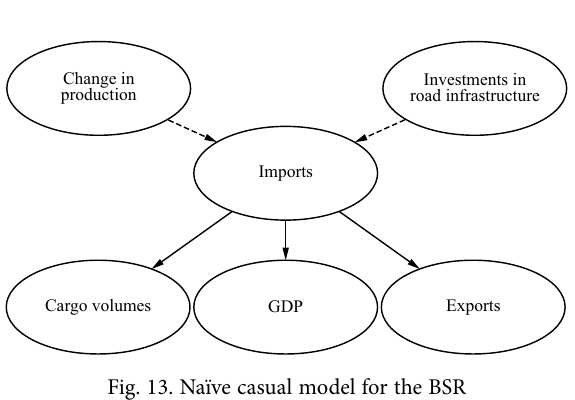
Fig. 13. Naïve casual model for the